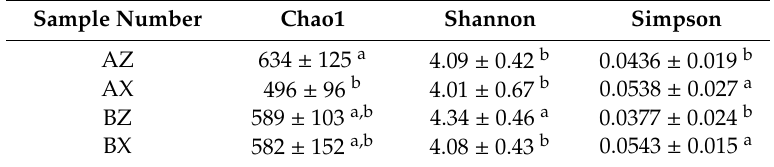
Table 3. Fungal microbial ‐ diversity index of plantation forest and original forest.